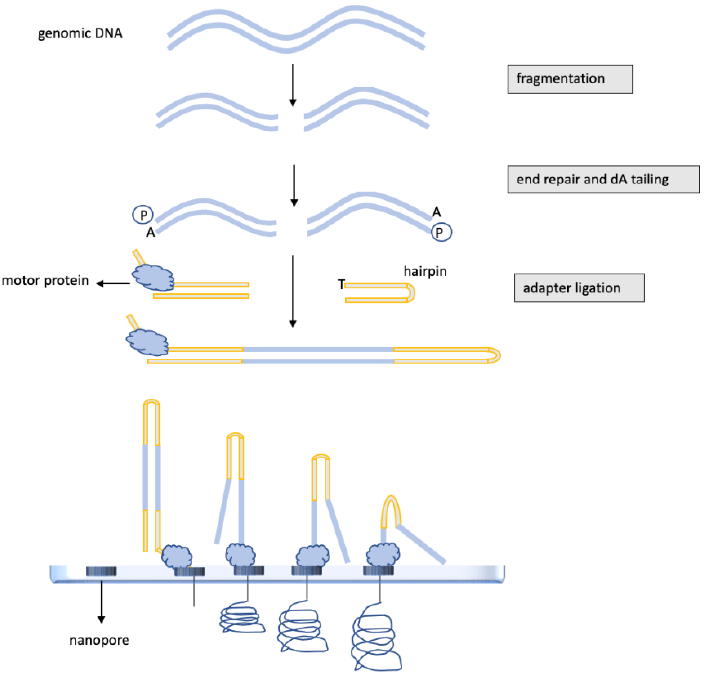
Figure 4. Nanopore sequencing strategy. As the first step, the genomic DNA is fragmented and then subjected to end repair and dA tailing. To allow DNA passage through flow cell pores, DNA is ligated to a protein adapter. Each flow cell may contain from 512 to 10,700 channels that may be potentially suitable for sequencing from 10 – 20 Gigabases to up to 100 Gigabases. Each channel is linked to a specific electrode, and a constant voltage is applied across the membrane. When double-stranded DNA molecules cross the pores, the voltage changes according to the specific single nucleotide passing the membrane. The difference in electric potential between the two sides of the membrane is converted into the specific nucleotide that may be identified in real-time during nanopore runs.